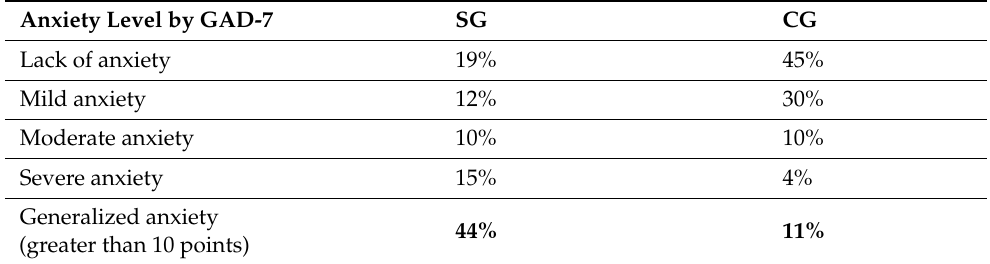
Table 1. Questionnaire responses of the study group (SG) and control group (CG) (N = 600). Anxiety Level by